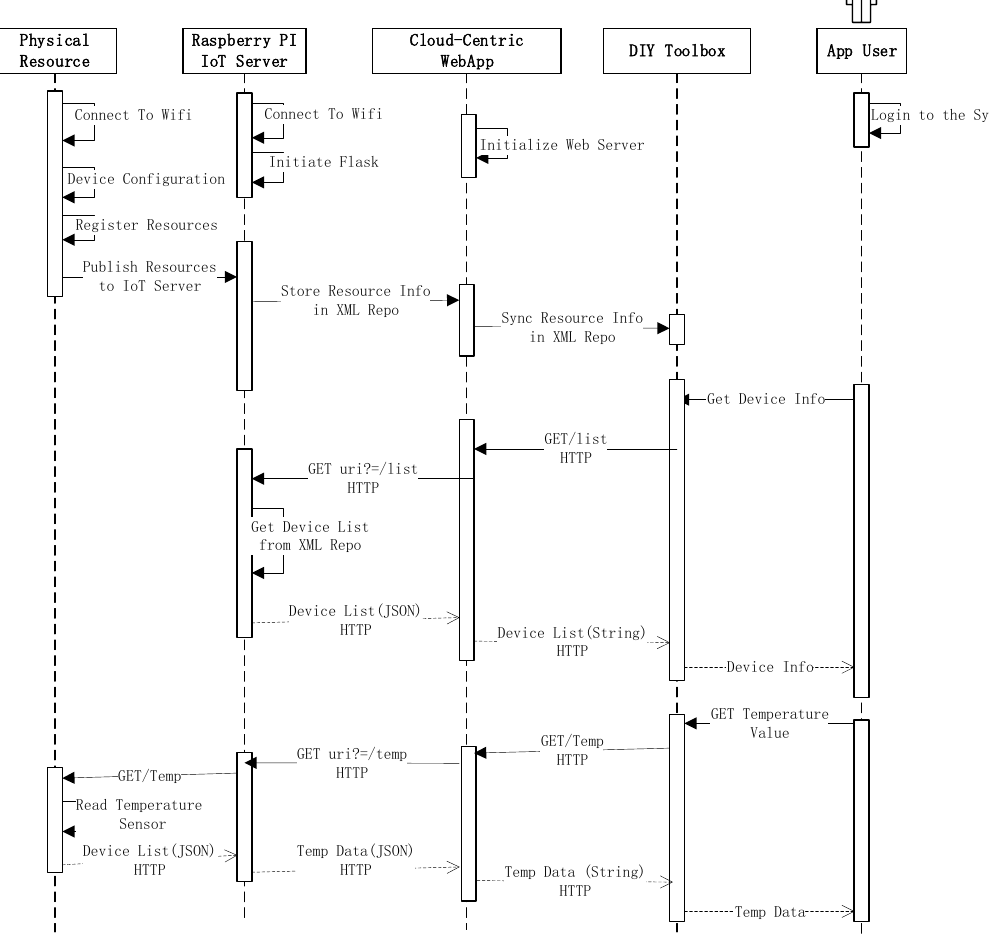
Figure 5. Sequence diagram of various operations within the proposed